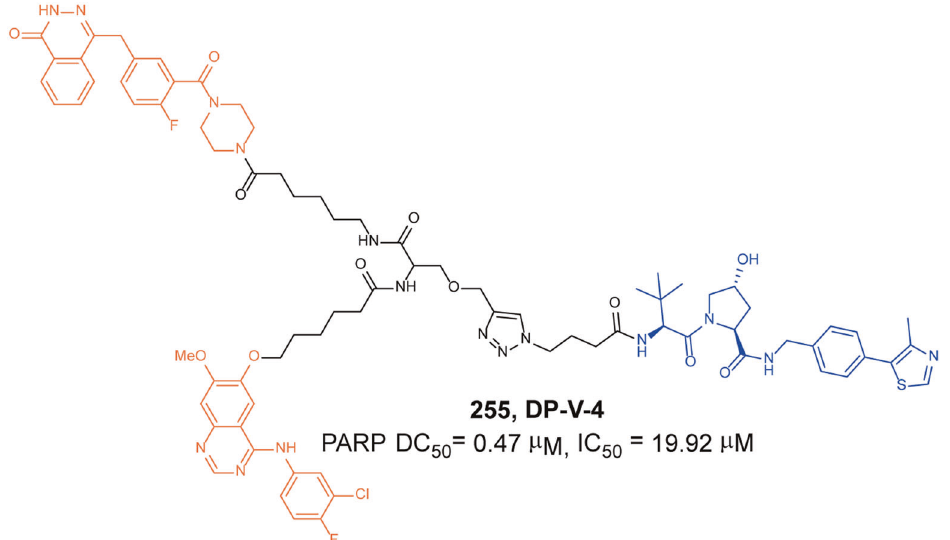
Fig. 84 The representative PROTAC of dual-target PROTACs